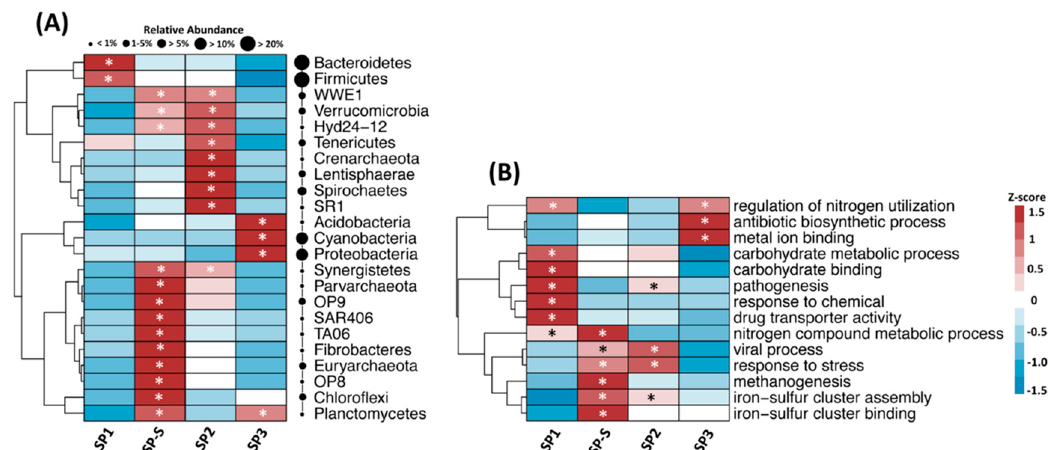
Figure 4. Heatmaps showing the differential abundance of ( A ) bacterial phyla and ( B ) functional categories in the on-site blackwater treatment system. The color key relates the heatmap colors to the standard score (z-score), i.e., the deviation from the row mean in units of standard deviation above or below the mean. Asterisks indicate significantly different group abundances based on the two-sided Welch’s t-test with Benjamini-Hochberg false discovery rate correction ( p < 0.05). The circles are proportional to the relative abundance of each phylum in all samples. Only phyla with significant differences between treatment modules are included in the figure.